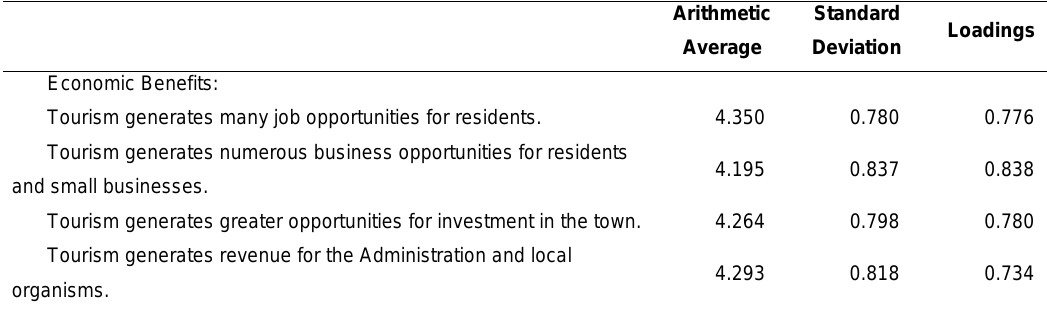
Table 3. Loadings of structural models